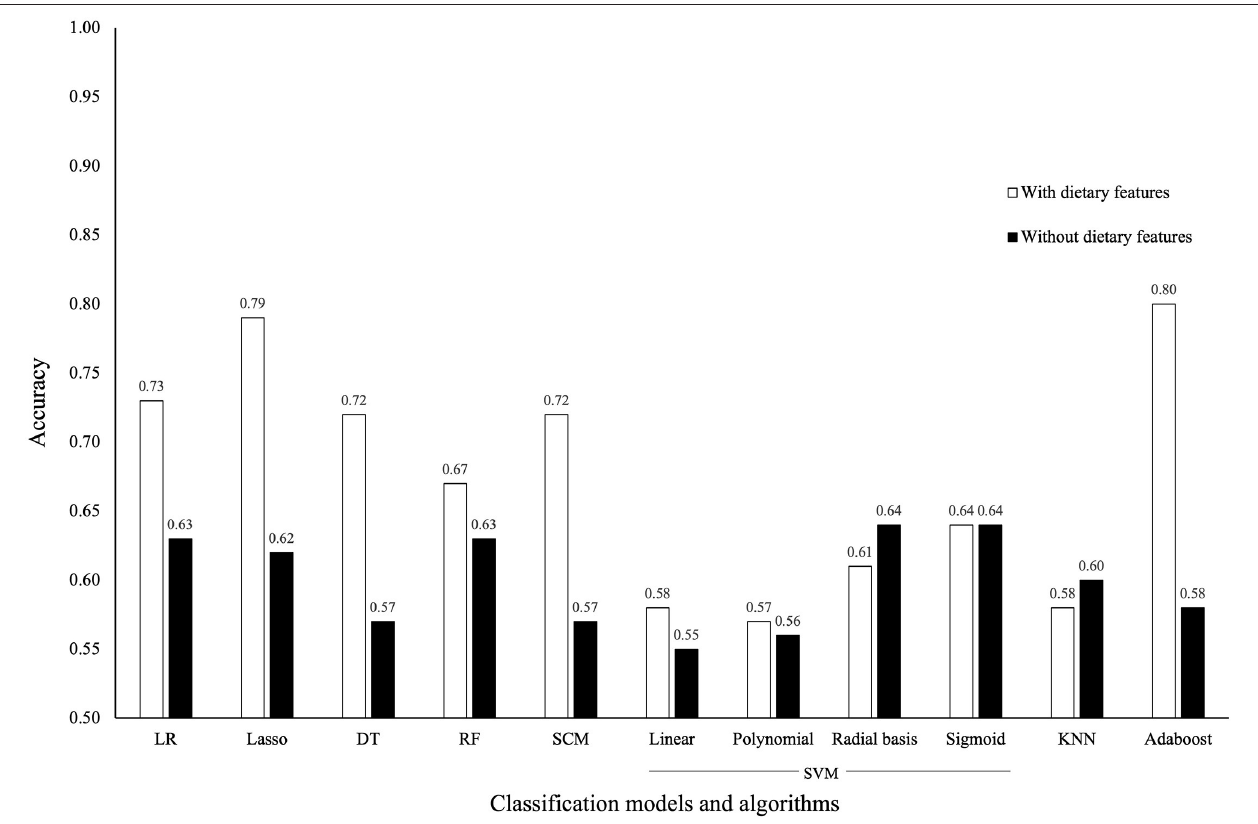
FIGURE 2 | Comparing the accuracy of traditional statistical models and machine learning algorithms to predict adequate vegetable and fruit (VF) consumption when other dietary intake features are included in addition to the 2452 features originally included. These are servings of grain products, milk and alternatives, meat and alternatives, as well as components of the Canadian Healthy Eating Index (C-HEI) other than the VF component and the C-HEI score itself. LR, logistic regression; DT, decision tree; RF, random forest; SCM, set-covering machine; SVM, support vector machine; KNN, k-nearest